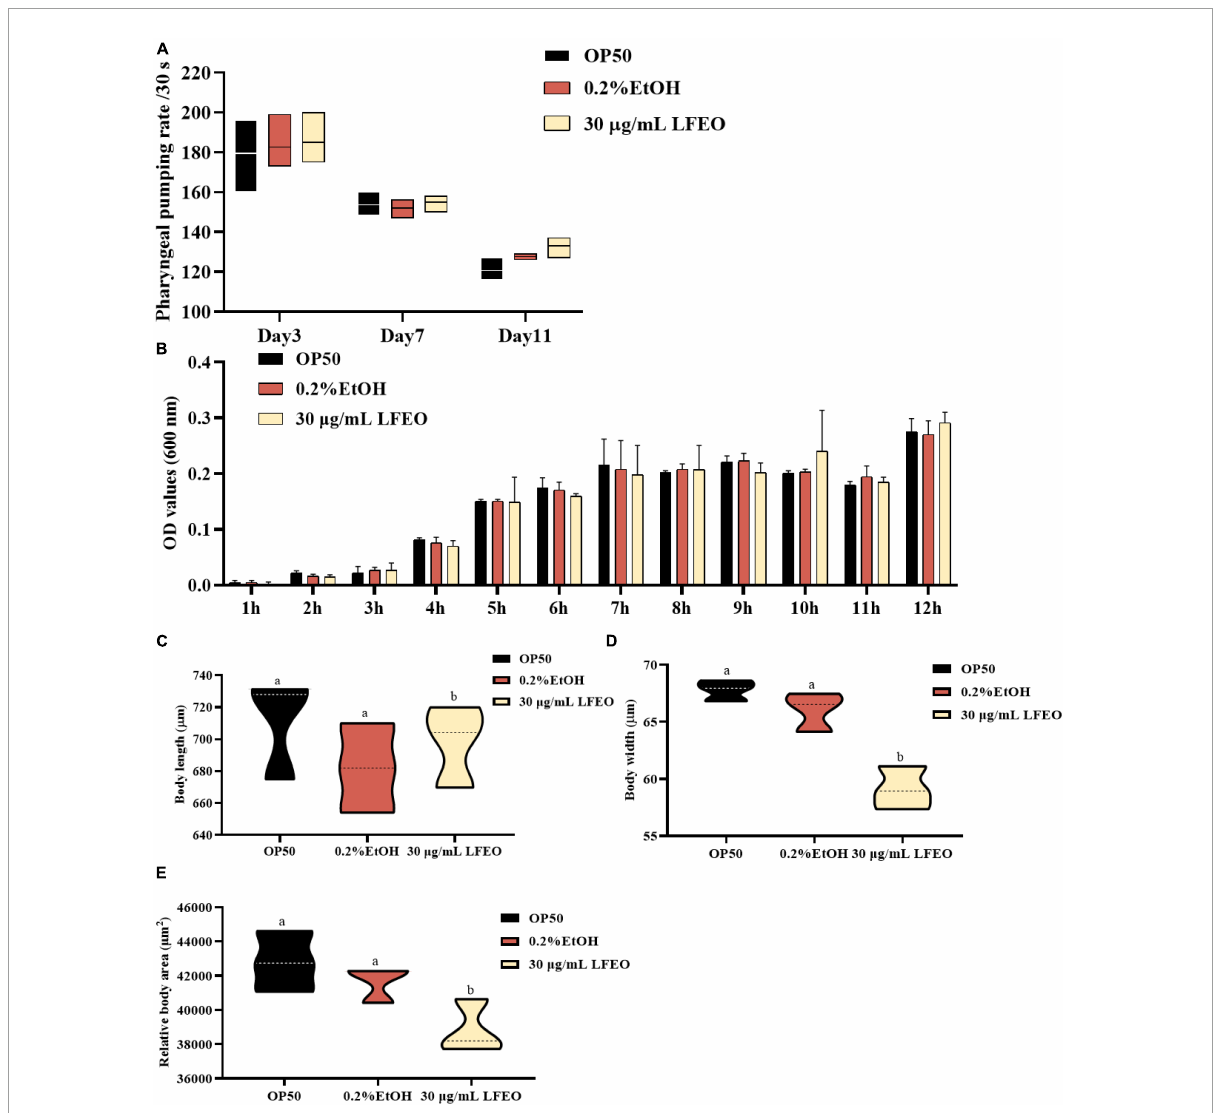
FIGURE5 The effect of litchi flower essential oil (LFEO) on energy intake of worms. (A) Pharyngeal pumping plays an important role in food intake which is involved in energy intake. The swallowing rate of nematodes at different periods was monitored. (B) E. coli OP50 , as the sole food source for nematodes is associated with energy intake. The effect of LFEO on the incubation of E. coli OP50 was determined. The effect of LFEO treatment on body length (C) , width (D) , and area of worms (E) . Statistical analysis of the results was done using a one-way ANOVA with Bonferroni tests as post hoc comparison; different letters indicate a significant difference, p < 0.05; with at least 10 worms per group in panels (A,C–E) , and three biologically independent samples in panel (B)